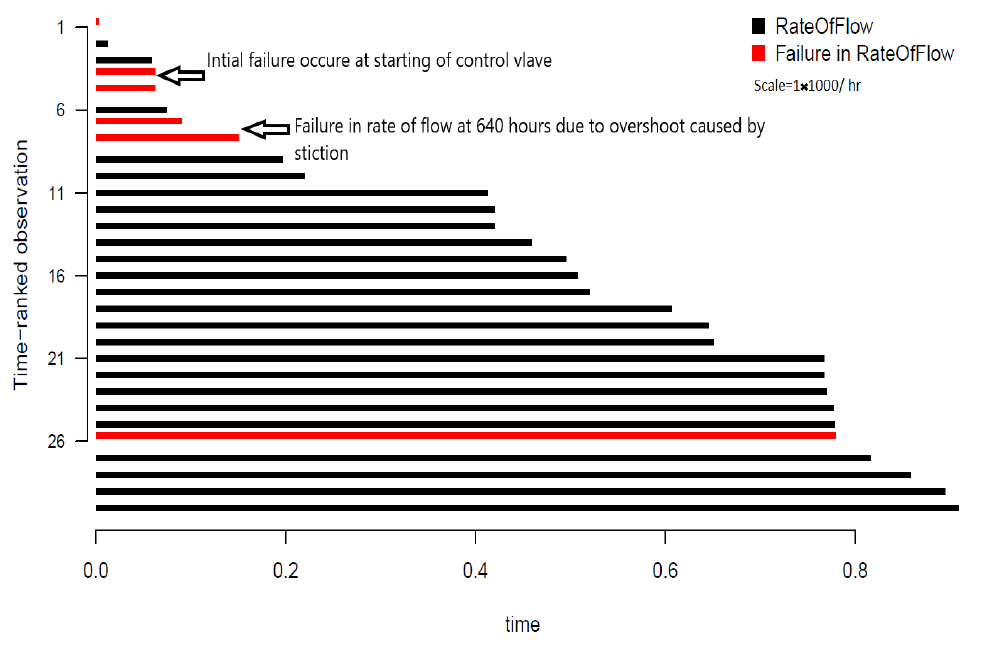
Figure 5. Censored failure data collected from